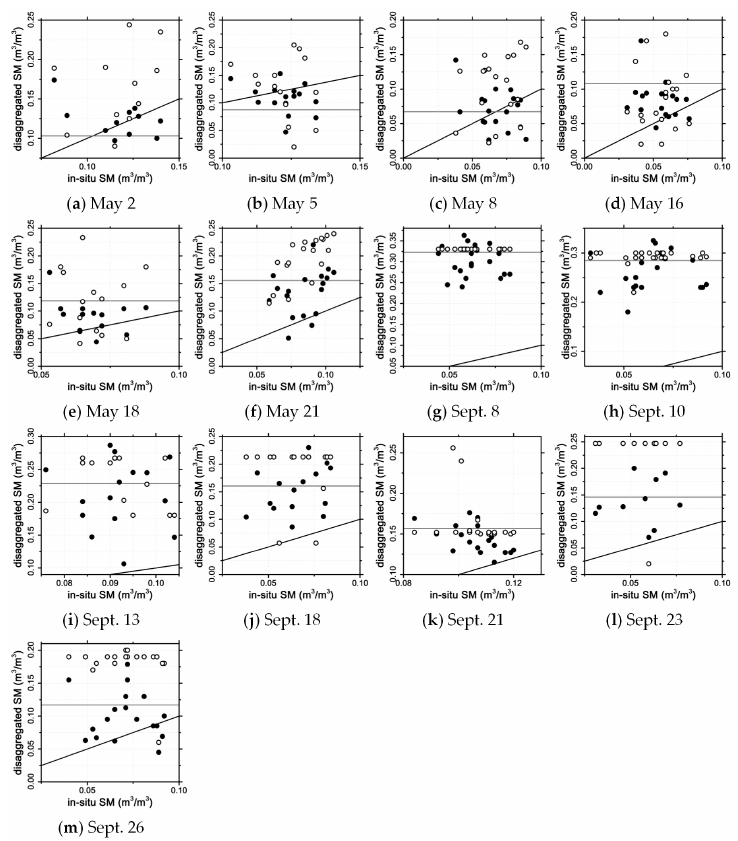
Figure 6. ( a – m ) Validation of the NRSD method. Black dotted data represent NRSD-derived soil moisture, and hollow circles represent disaggregation based on physical and theoretical scale change (DISPATCH)-derived soil moisture at 1 km resolution. The black line denotes the 1:1 line, and the gray line denotes the SMAP soil moisture at 36 km resolution.